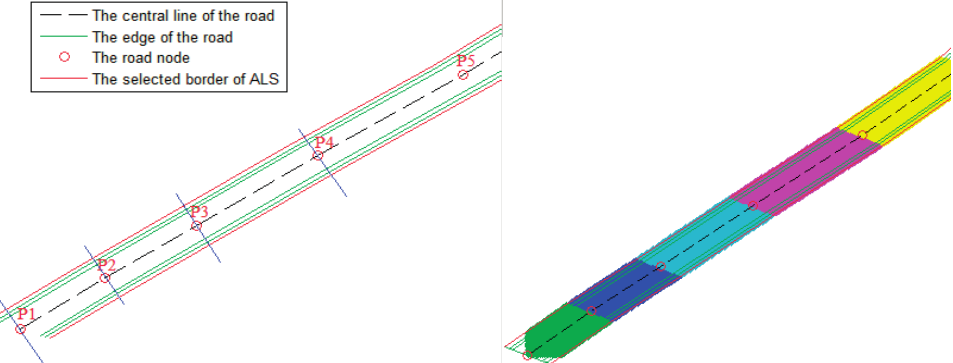
Figure 14. Road patch segmentation. ( Left ) lines of segmentation (blue line) vertical to the road surfaces through the key points; ( Right ) ALS ground points segmented into multiple